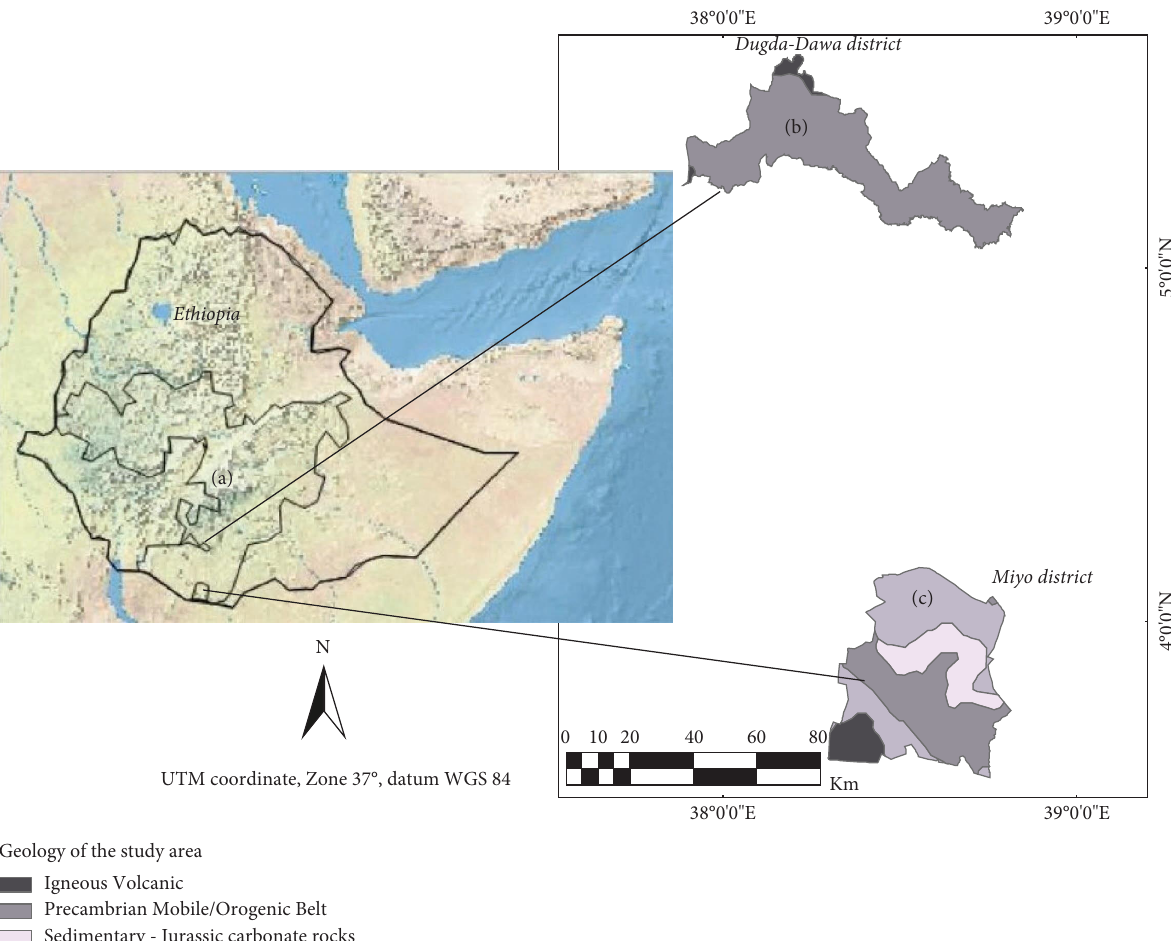
Figure 1: Te study area. (a) Te districts in Oromia Regional State, Ethiopia. (b, c) Te map of the study area with geological features of the Dugda Dawa and Miyo districts, respectively. Geological information is derived from ´O Dochartaigh